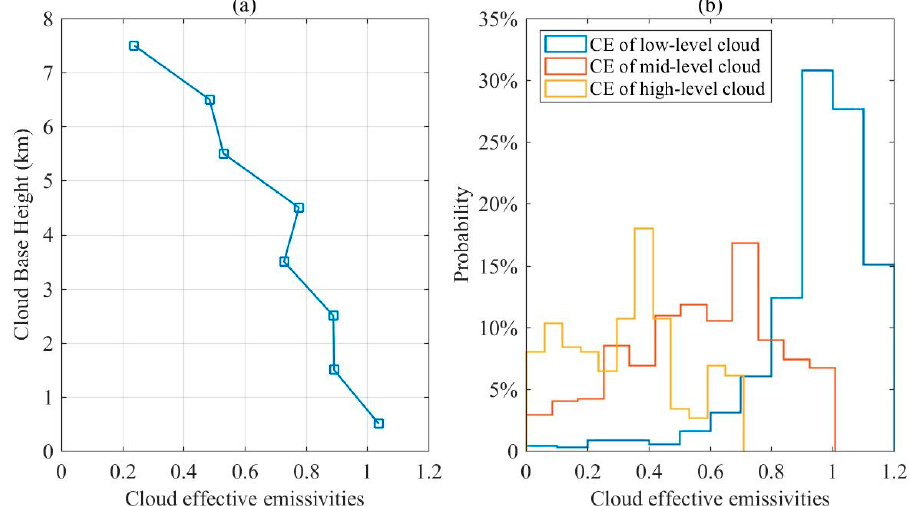
Figure 8. Cloud effective emissivities for different cloud base heights. ( a ) the average cloud effective emissivities for cloud layers at different height (0–1 km, 1–2 km, 2–3 km, 3–4 km, 4–5 km, 5–6 km, 7–8 km); ( b ) histograms of effective emissivities for low-level, mid-level, and high-level clouds.